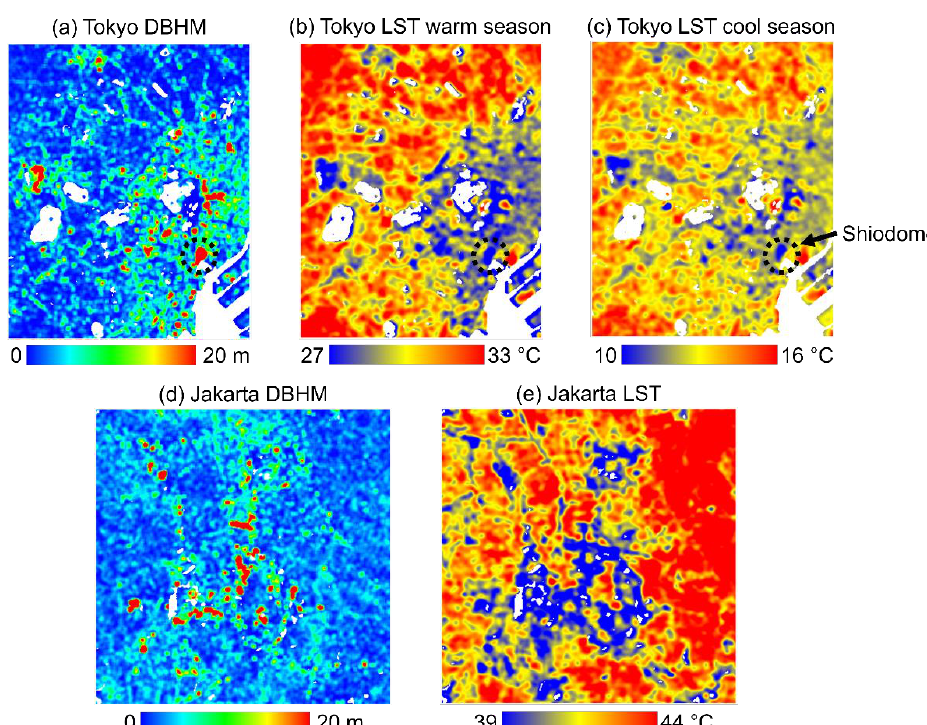
Figure 8. The averaged version of ( a ) Tokyo digital building height model (DBHM), ( b ) Tokyo land surface temperature (LST) warm season, ( c ) Tokyo LST cool season, ( d ) Jakarta DBHM, and ( e ) Jakarta LST. In ( a – c ), the circled part is the Shiodome area that shows very high height values than in other areas.